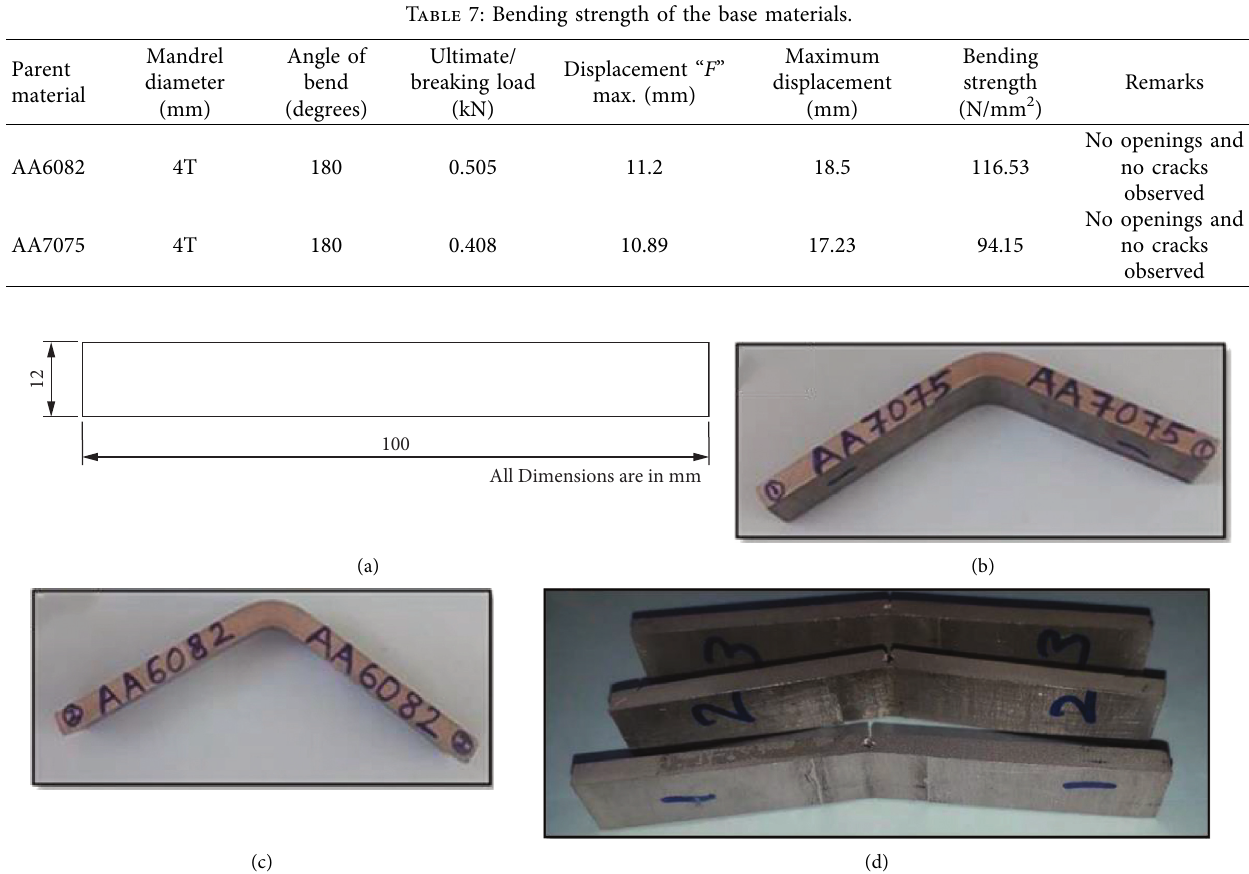
Figure 5: (a) Top view of bend sample as per the ASTM standard. (b, c) Photographic view of base material bend samples. (d) Photographic view of bend samples after the experiment.